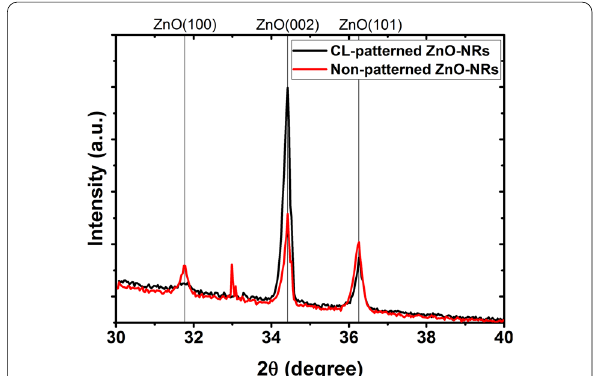
Fig. 6 XRD diffraction pattern of CBD-grown ZnO NRs on similar non-patterned and CL-patterned seed layers